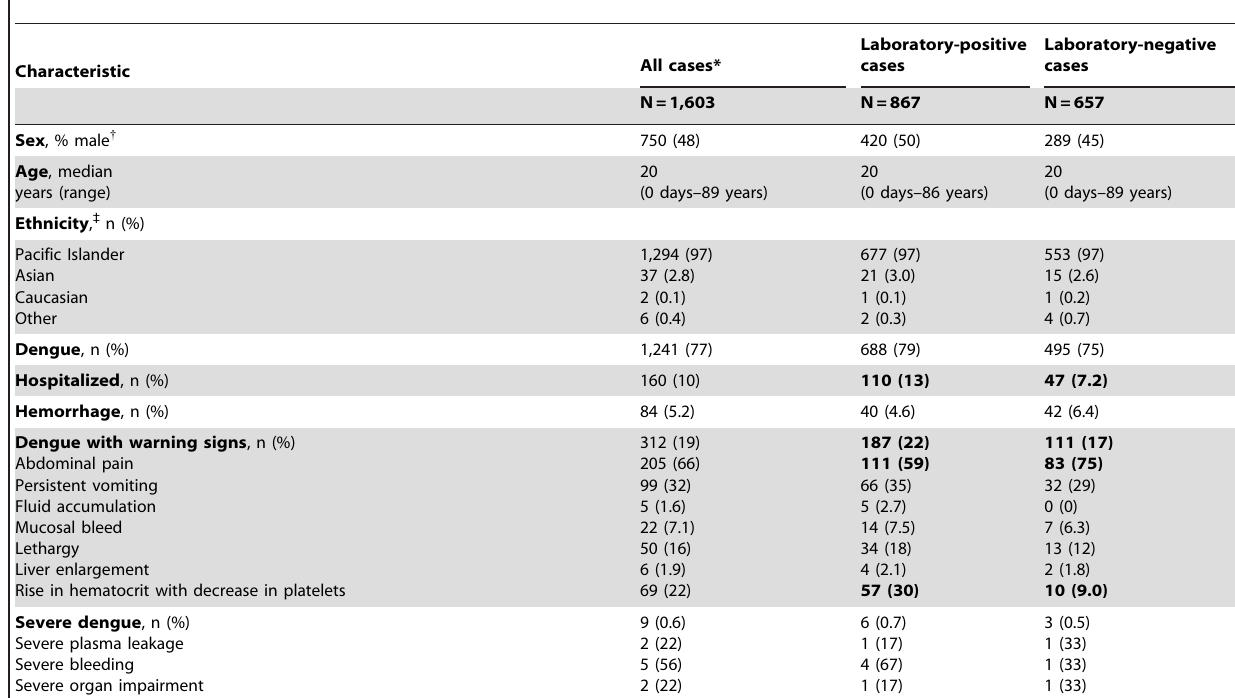
Table 1. Demographic and clinical characteristics of suspected dengue cases reported during an outbreak in the Republic of the Marshall Islands, October 2011–February